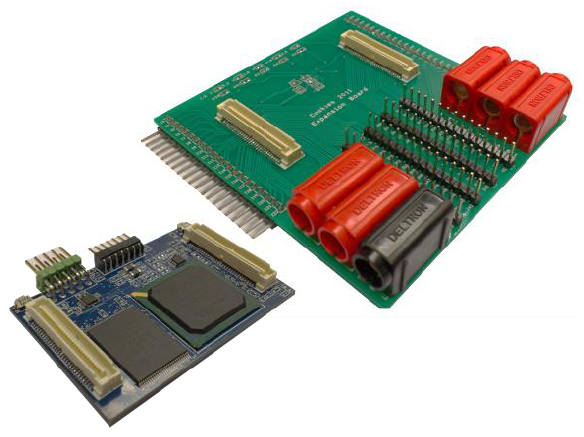
Figure 3. HiReCookie on the left side and expansion board for debugging on the right